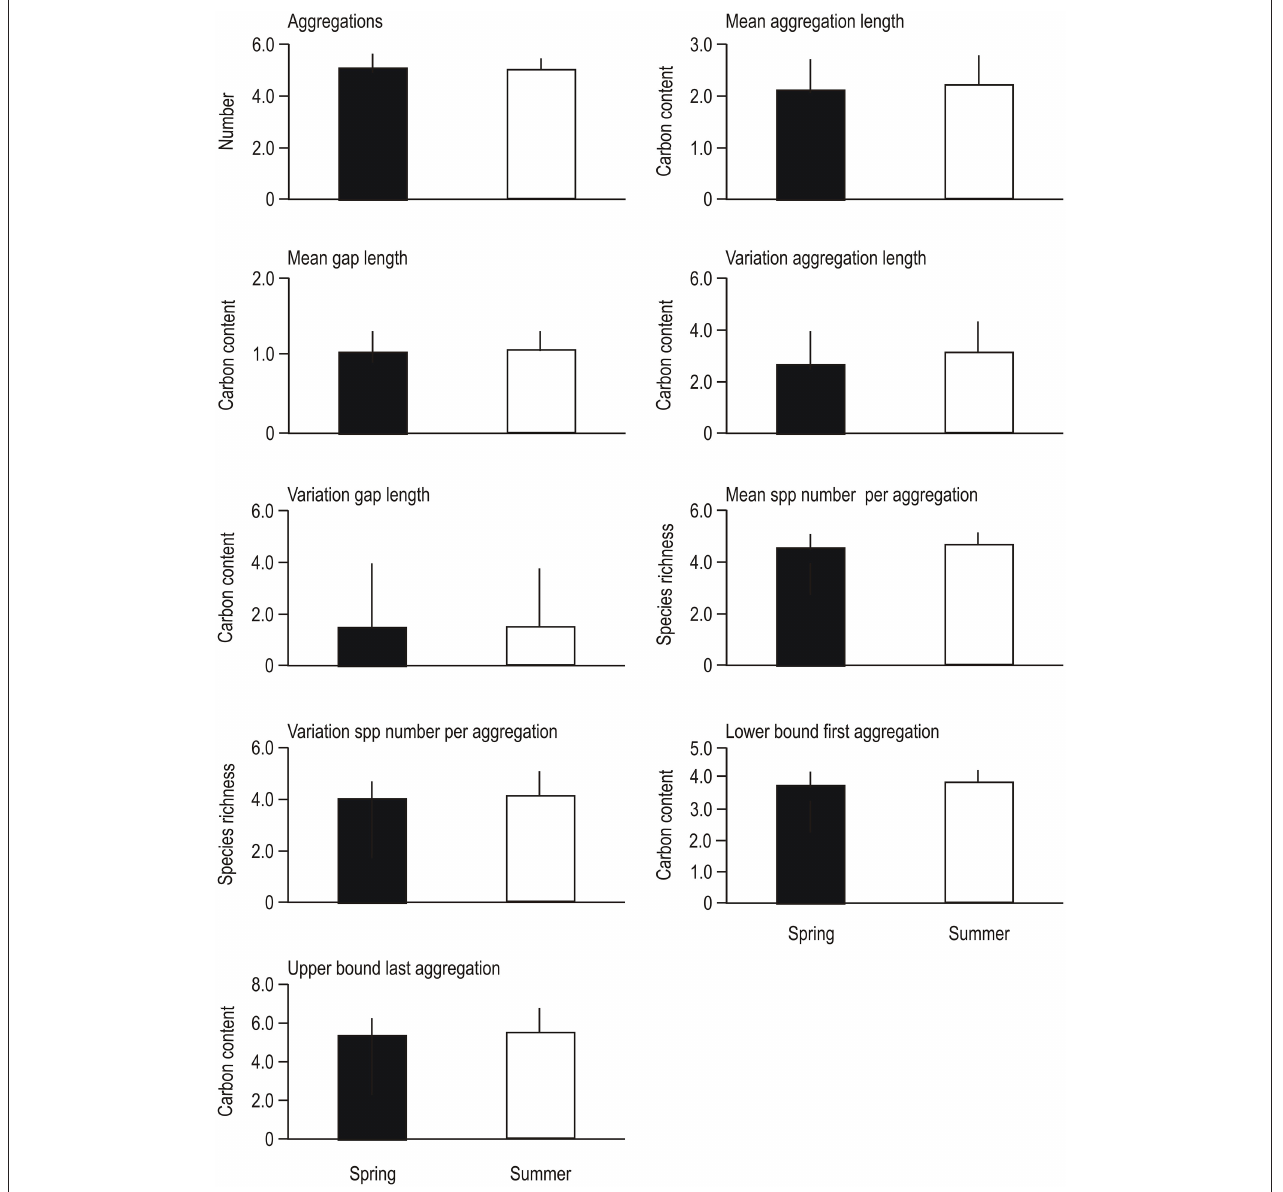
FIGURE 2 | Comparison of resilience metrics based on the cross-scale resilience model used for analysis. Shown are the means and standard deviations from 3 yearly measurements for each site (coastal and offshore) for the study period 2007–2011 ( n = 36). See section Materials and Methods for descriptions and calculations of these